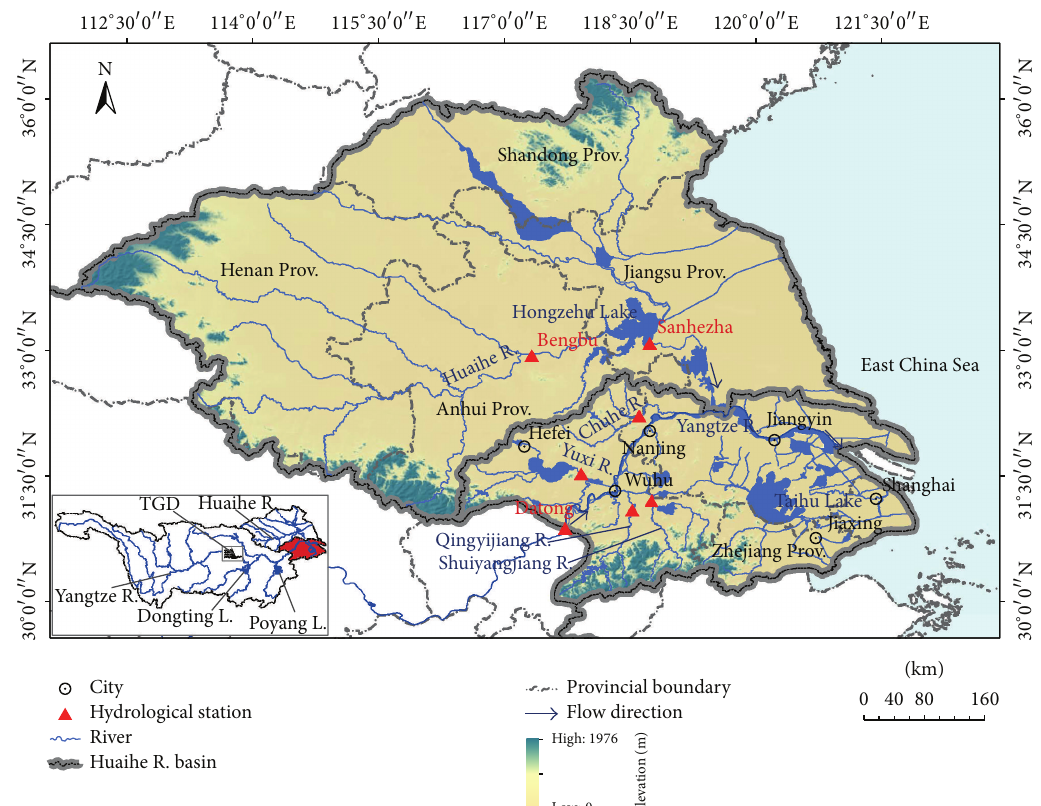
Figure 1: Map of the study